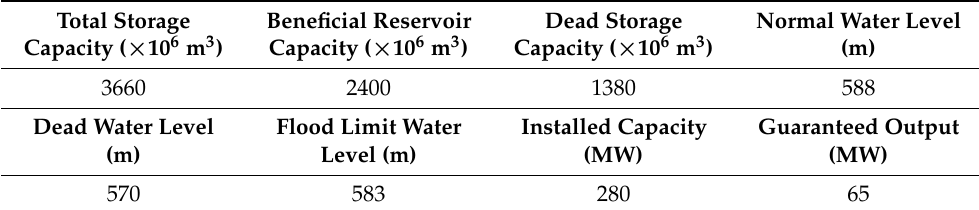
Table 1. Some parameter indexes of hydropower